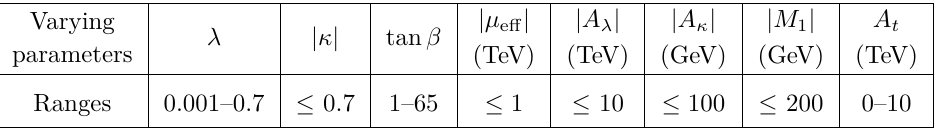
+ m 2 + m 2 ) / 4 , except for e Q e U e D , is kept fixed at 2.5 TeV. 2